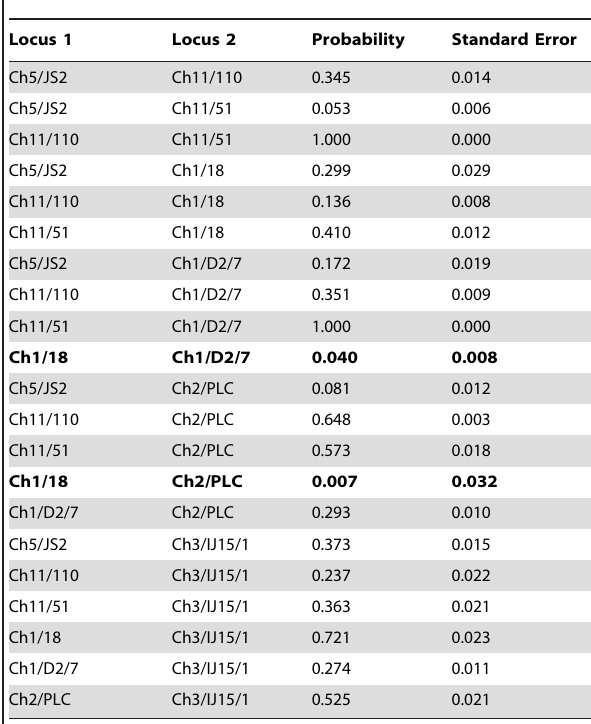
Table 7. Linkage disequilibrium for each genetic marker (statistically significant disequilibrium highlighted in bold) between pair wise polymorphic loci in the combined T. b. brucei and group 2 T. b. gambiense population at the Coˆte d’Ivoire focus (N